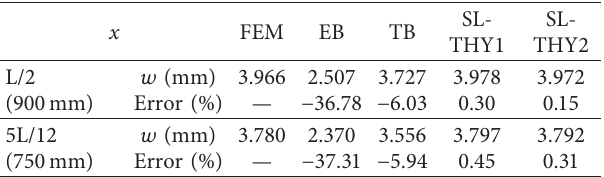
Table 6: Vertical deflections of midspan and 5/12-span of the fixed- end box girder